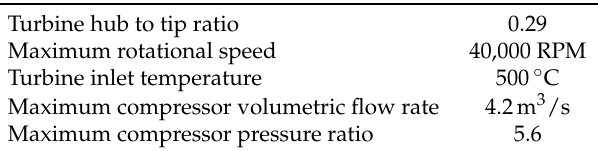
Table 1. Test rig geometry and measurement boundary